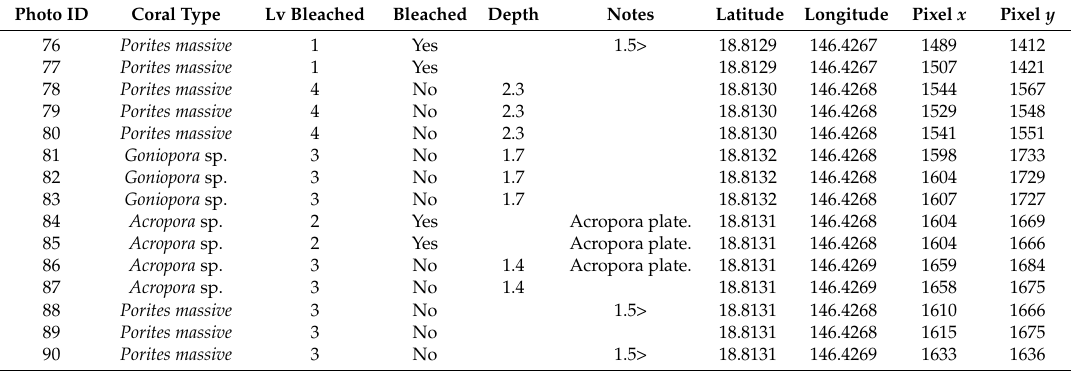
Table 2. Fragment of the attribute table at Pandora Reef (14 of 64 in-water data collected